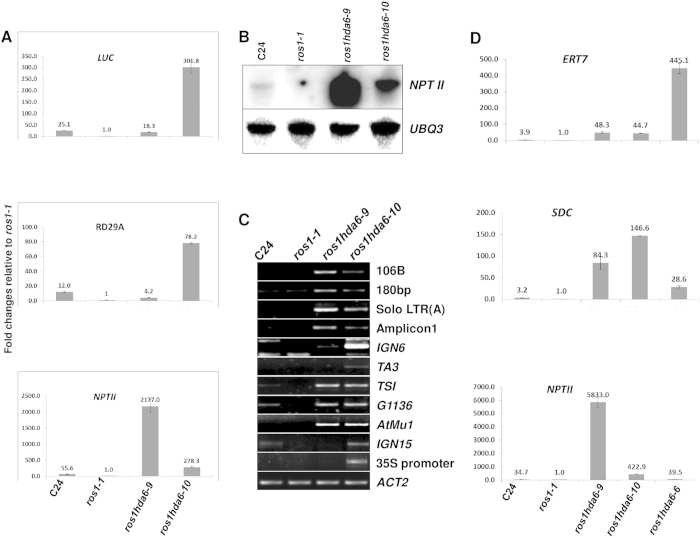
Transcriptional gene silencing is suppressed in the hda6–9 and hda6–10 mutant plants.(A) Expression levels of LUC (upper panel), endogenous RD29A (middle panel) and NPTII (lower panel) relative to those in ros1–1 were measured with qRT-PCR using UBQ3 as an internal reference. The Y-axis represents the fold changes compared to ros1–1. Ten-day-old seedlings were treated at 4 °C for 1 day, and then total RNAs were extracted for analyzing the expression of the reporter genes and endogenous genes. (B) RNA blot assays showed the expression level of NPTII in wild type, ros1–1, hda6–9, hda6–10 and ros1 ago4. UBQ3 was used as a loading control. (C) Expression of selected endogenous targets of HDA6 determined by RT-PCR with random hexamer primers. ACT2 (ACTIN2) (its CT mean in all 4 samples with 20 cycles) was used as an internal reference. (D) Relative expression of Group E target ERT7, 35S::NPTII, and SDC among the two hda6 mutated alleles and ros1 hda6–6 (the hda6 null mutant axe1–5 in the ros1–1 background). Data are means and standard derivations based on 3 biological replicates.